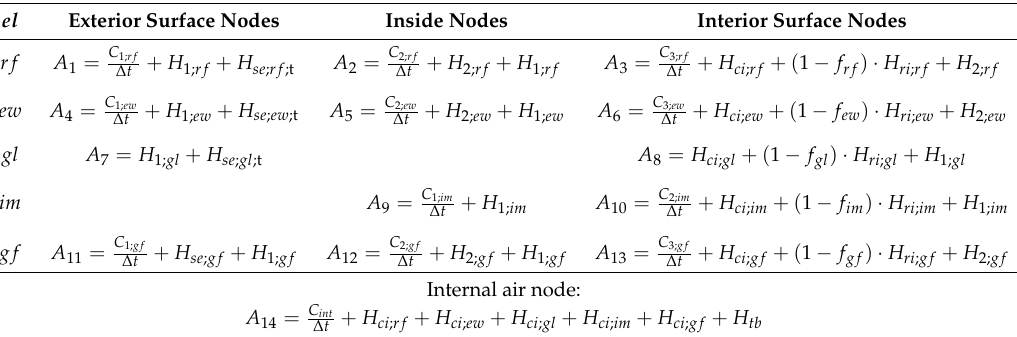
Table A1. Elements A 1 , · · · , A 14 of matrix A . el refers to the five building element types. el Exterior Surface Nodes Inside Nodes